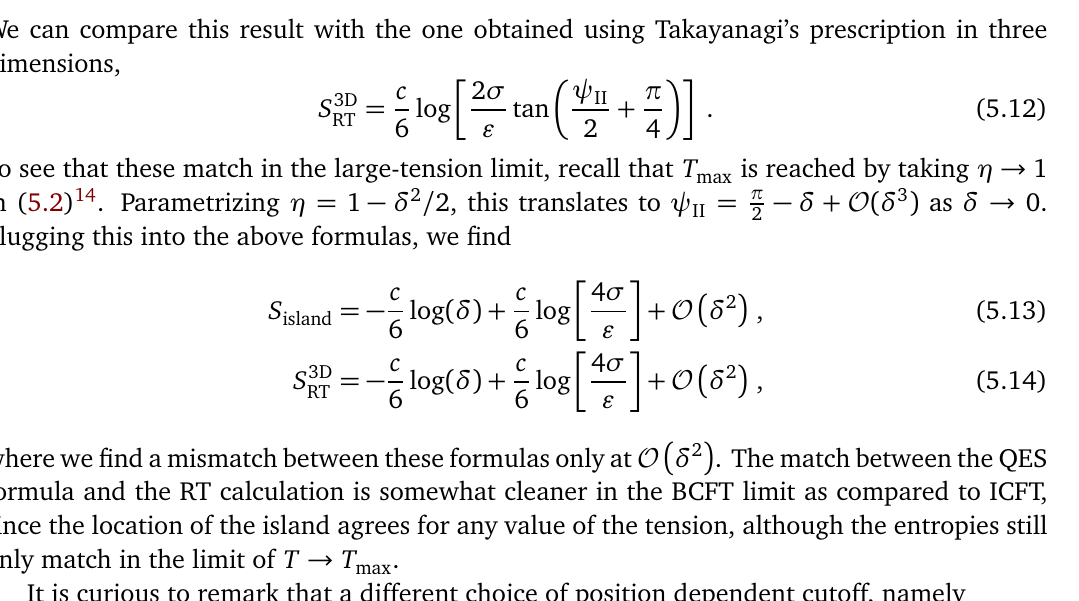
Figure 14: The various geodesic saddles in BCFT, recovered from the ν → 0 limit of